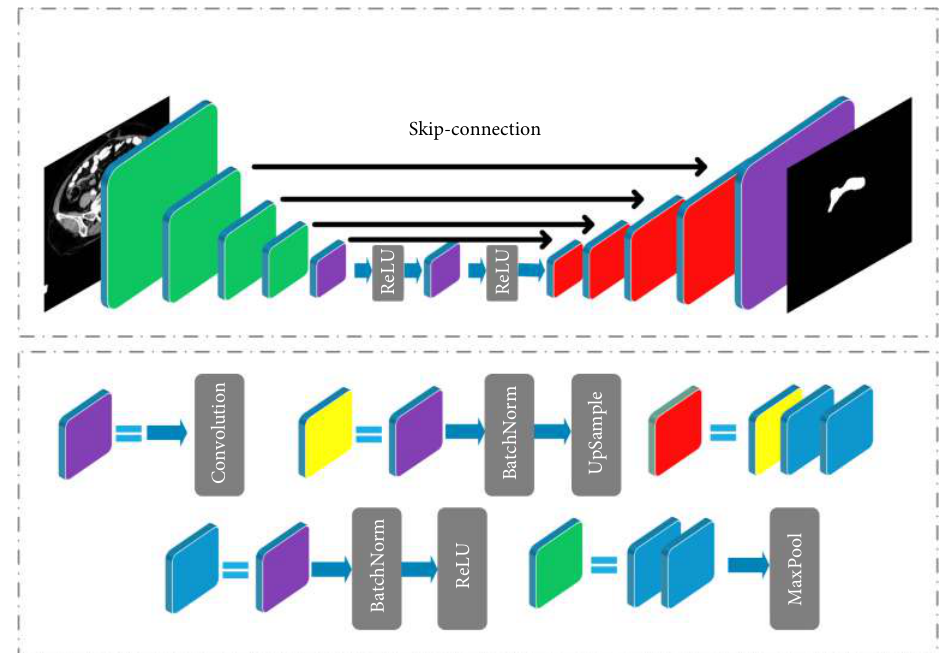
Fig. 1 Network structure. Here, convolution is a linear transformation that can extract 2D image features. BatchNorm is a normalization operation to speed up the training process. MaxPool and UpSample are to halve and double the image resolution, respectively. ReLU is an activation function to apply a nonlinear operation in a network structure whose expression is max (0,